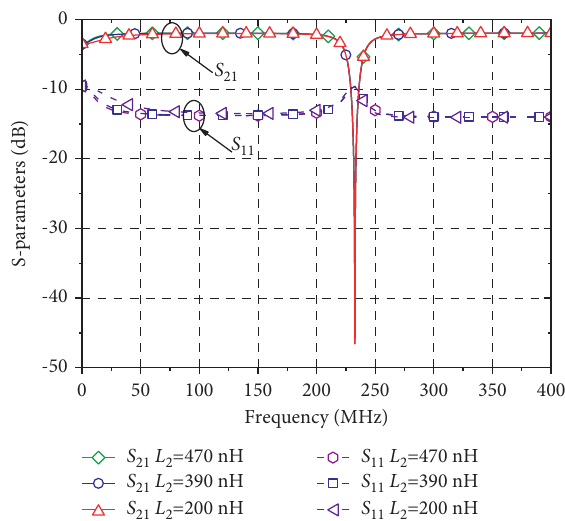
Figure 19: S parameters of the band-stop filter with low-pass negative group delay